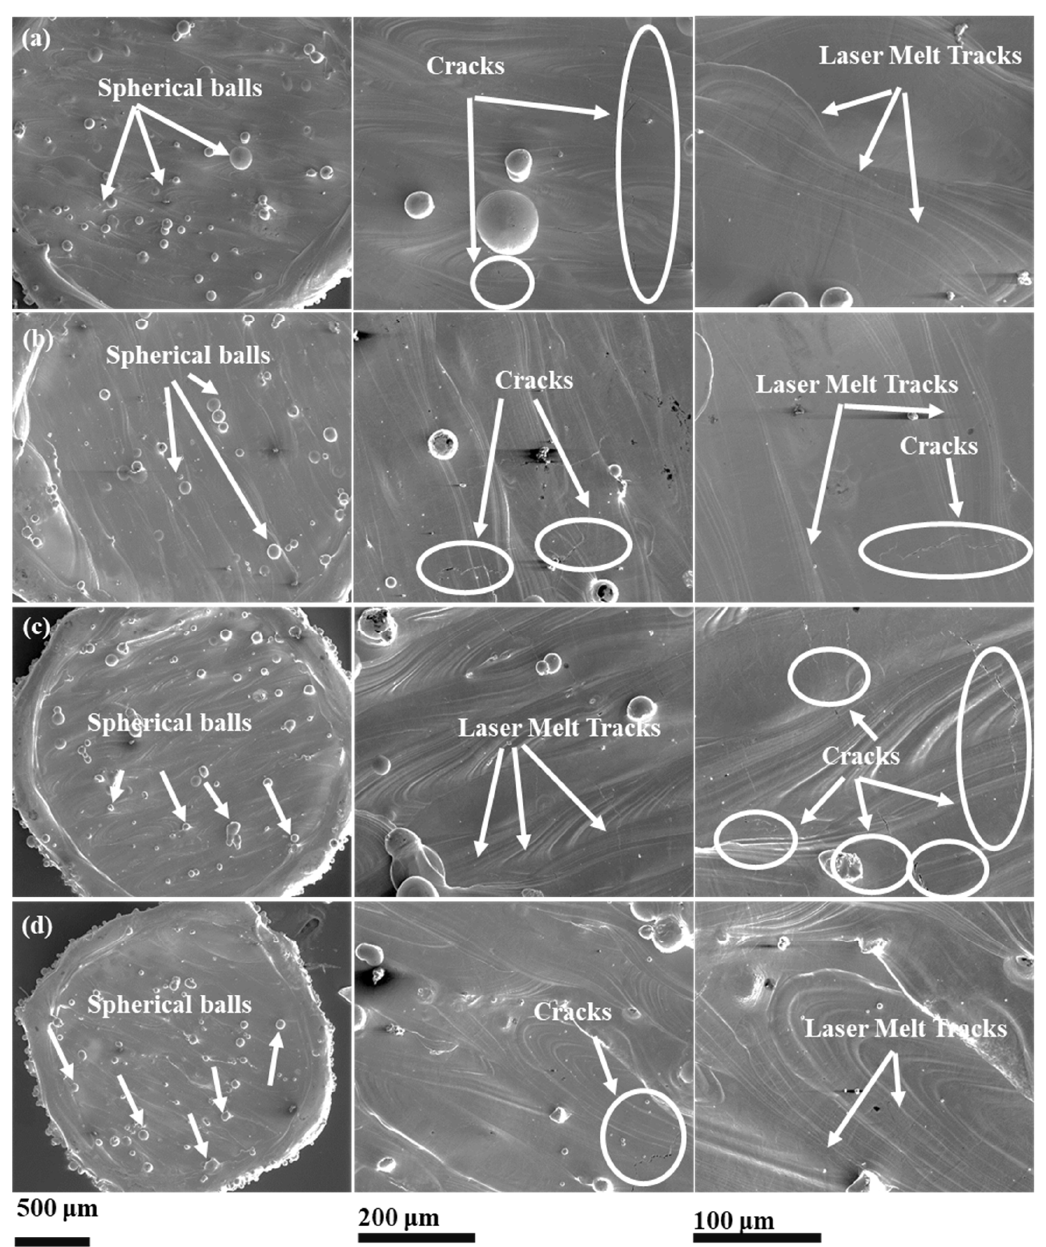
Figure 7. SEM images of primitive lattice structures additively manufactured using different scan strategies ( a ) S1, ( b ) S2, ( c ) S3, and ( d ) S4.